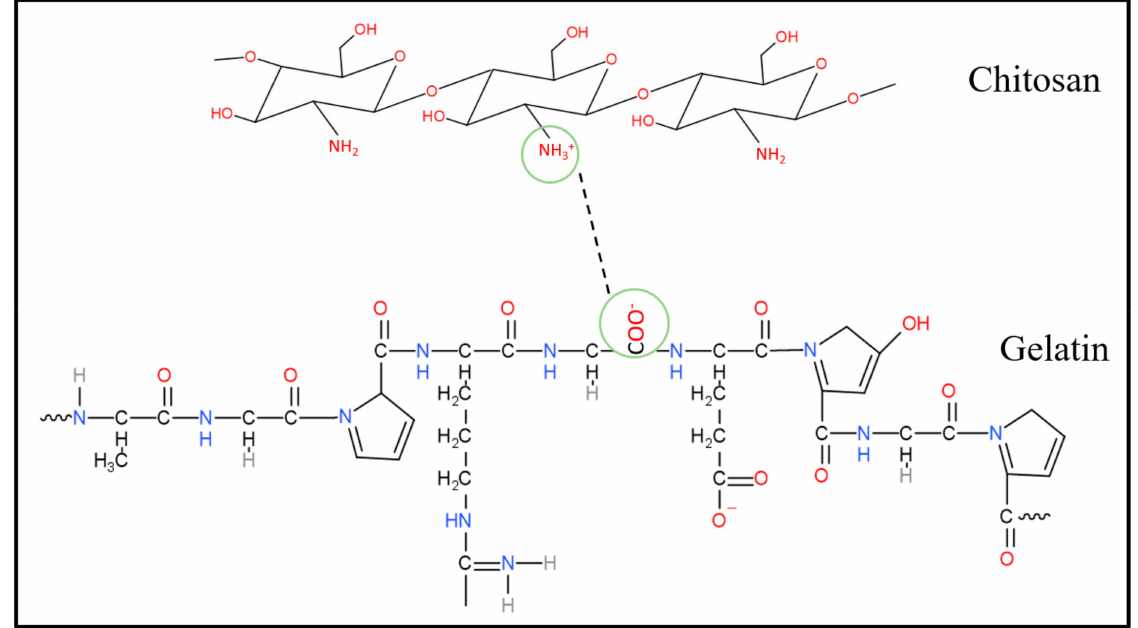
Figure 7. Chemical interaction between the hydroxyl group of agaroses and the ether group of chitosan.